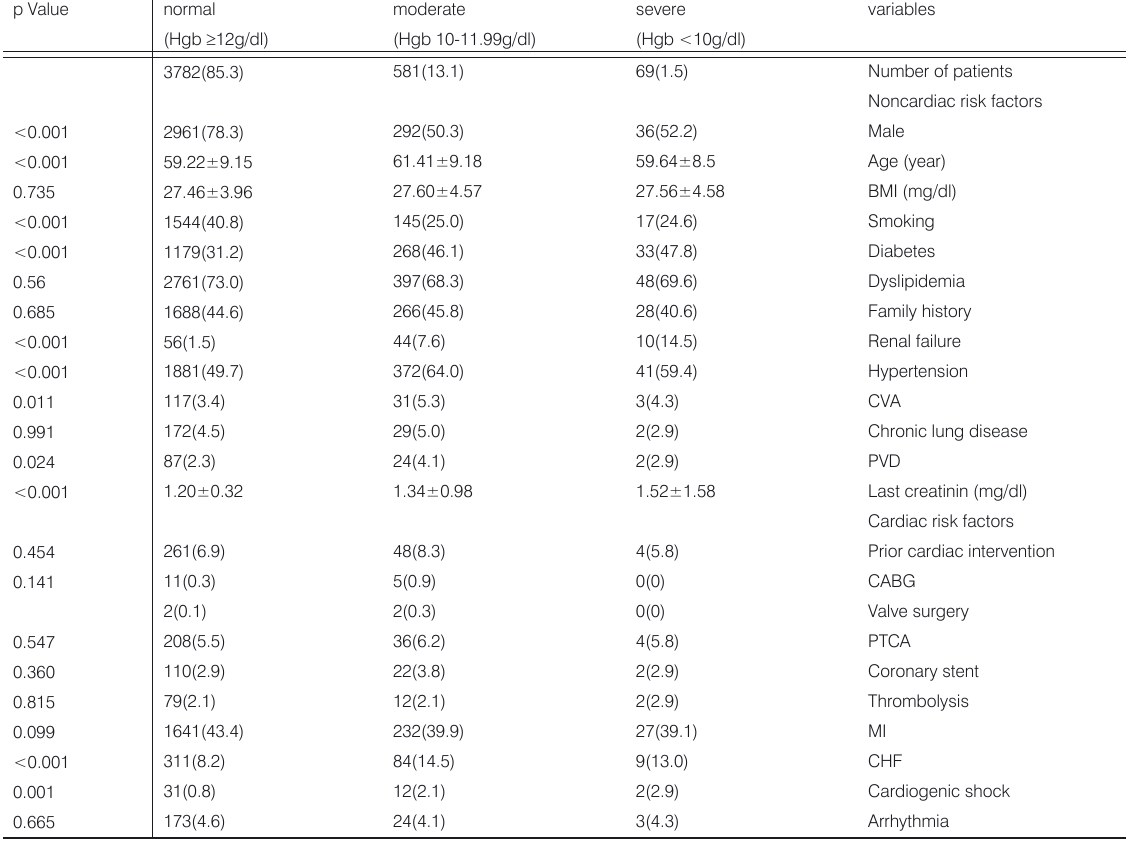
Table 1. Patient characteristics (n= 4432) by preoperative Hgb classification.